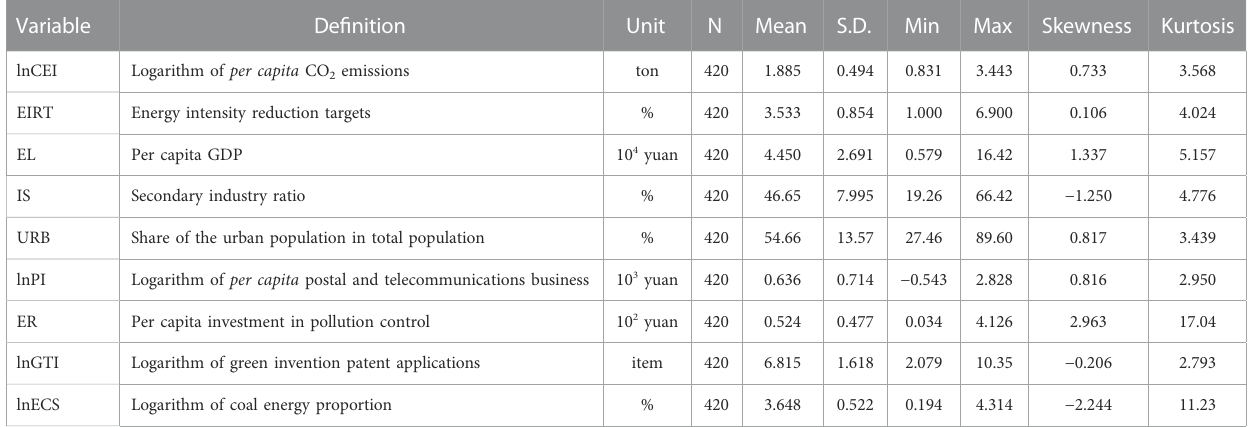
TABLE 1 Descriptive